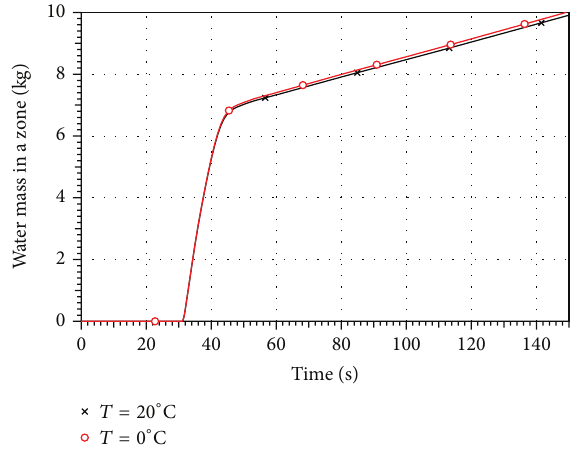
Figure14:Failureofopeningofburstdiskat1.1 bar:totalwatermass in piping.